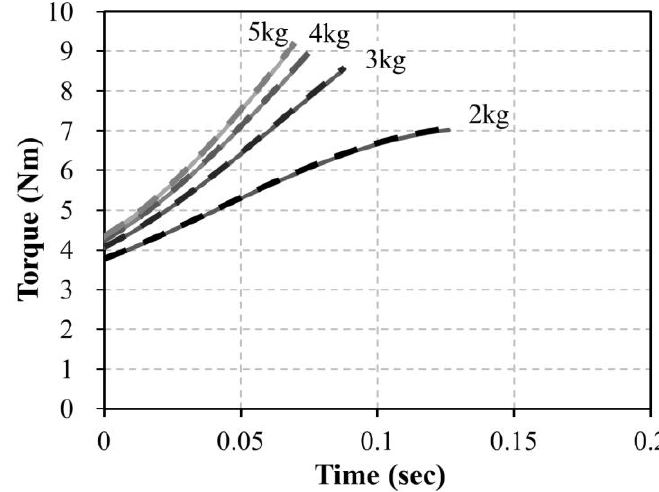
Figure 5. Simulation results for the driving torque in Equation (1) (dashed line) and calculated torque in Equation (2) (solid line) with extension springs for 2~5 kg dropping weights.